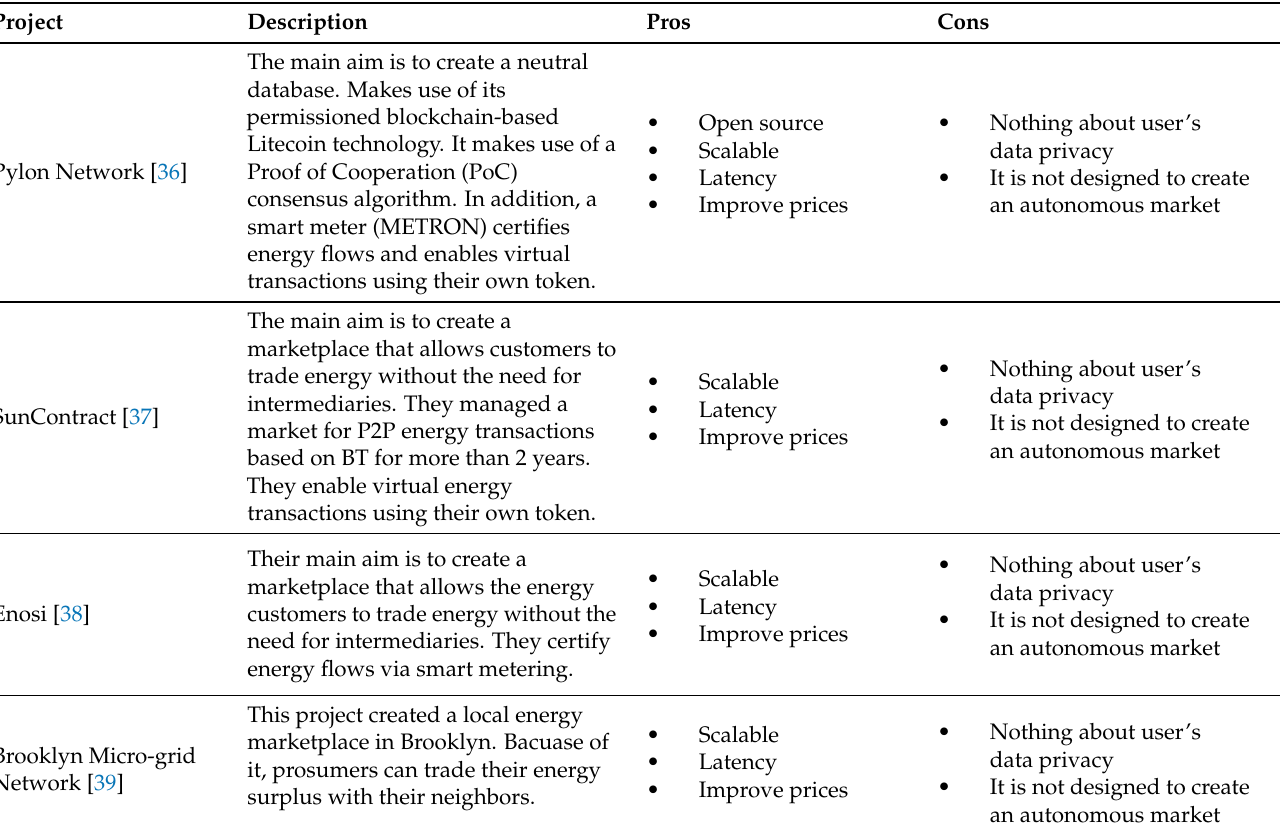
Table 2. Comparison of the studied